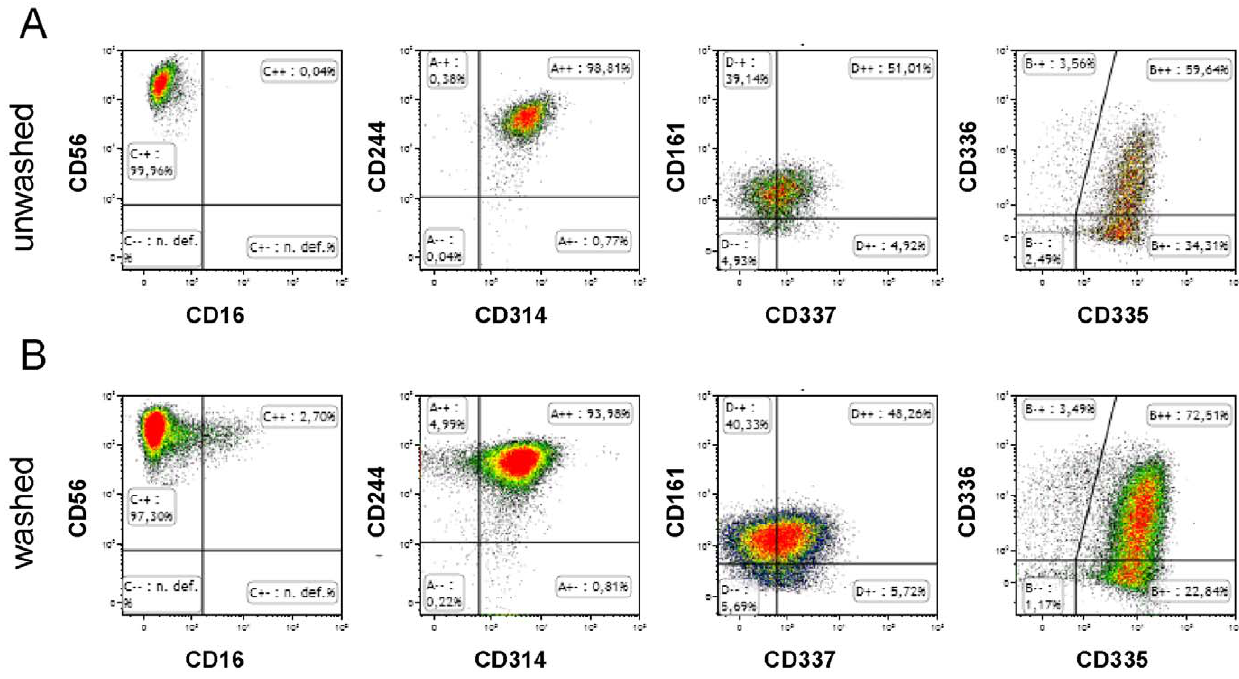
Figure 3. Flow cytometry analysis of e xvivo bioreactor-expanded NK cells before and after washing. The CD56 + CD3 2 lymphocytes were analyzed of unwashed ( A ) and washed ( B ) NK cell products. A representative example out of three different NK cell products is shown.